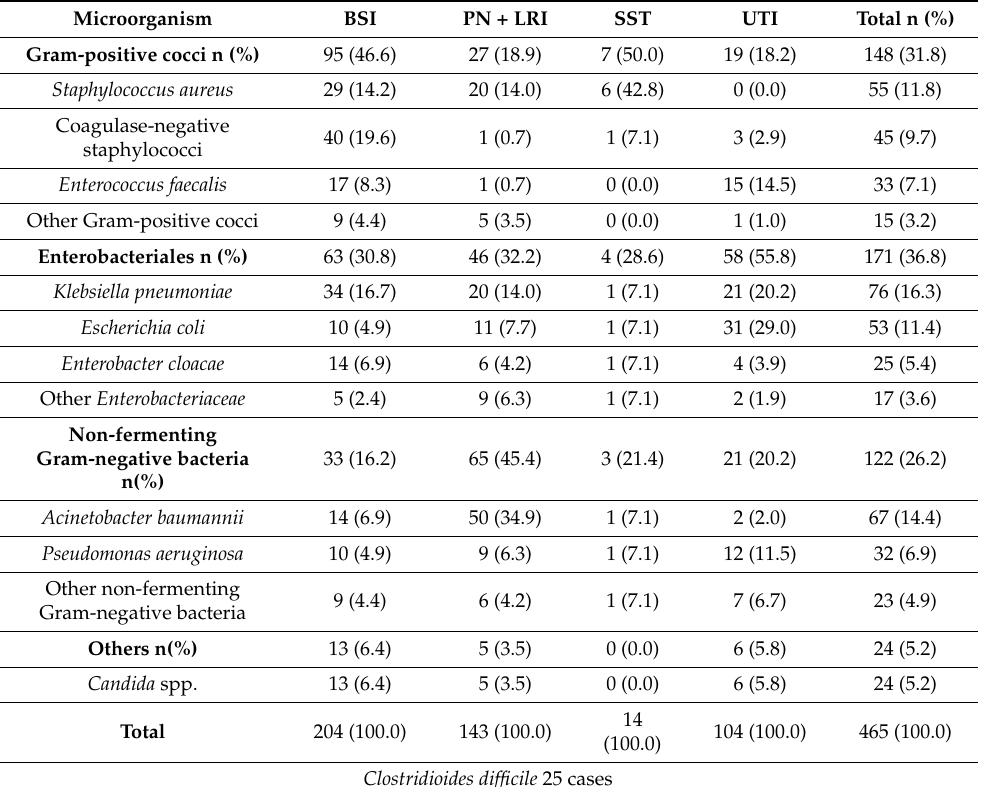
Table 5. Microorganisms causing HAI isolated in microbiological testing, clinical forms of HAI in ICU in